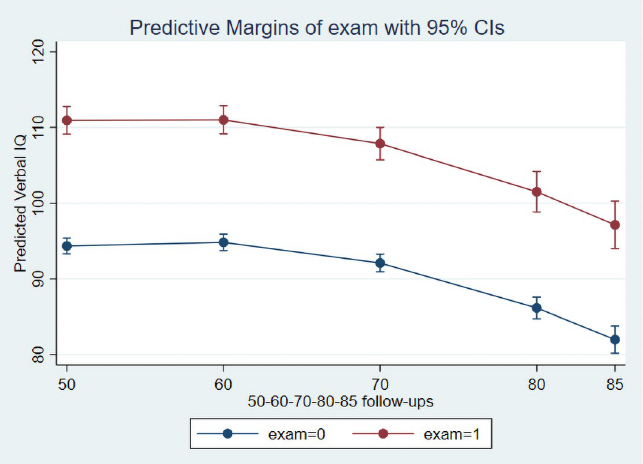
Fig 1. Decline of Verbal IQ stratified on education over a 35-year follow